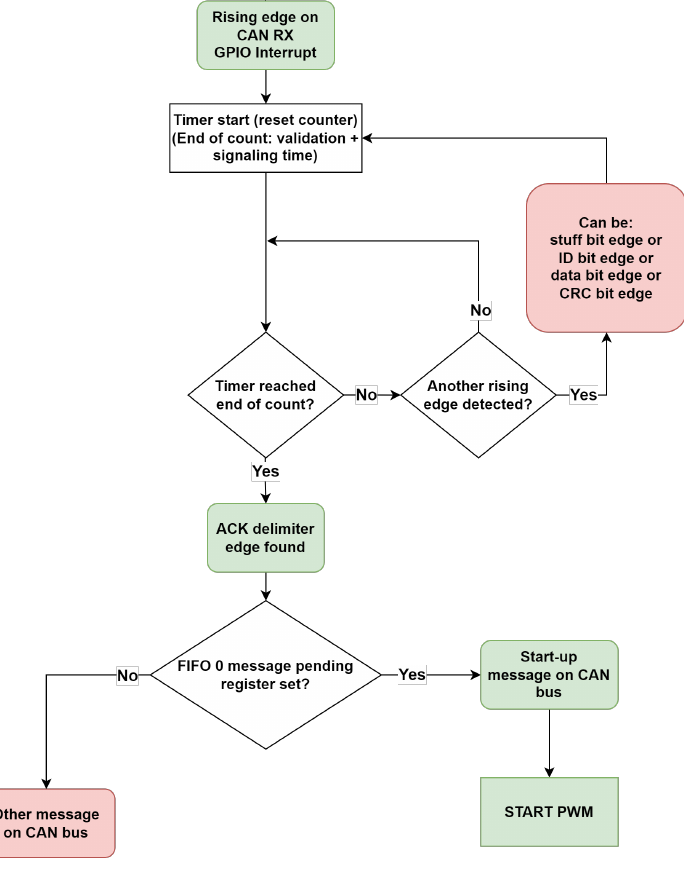
Figure 4. Start message detection